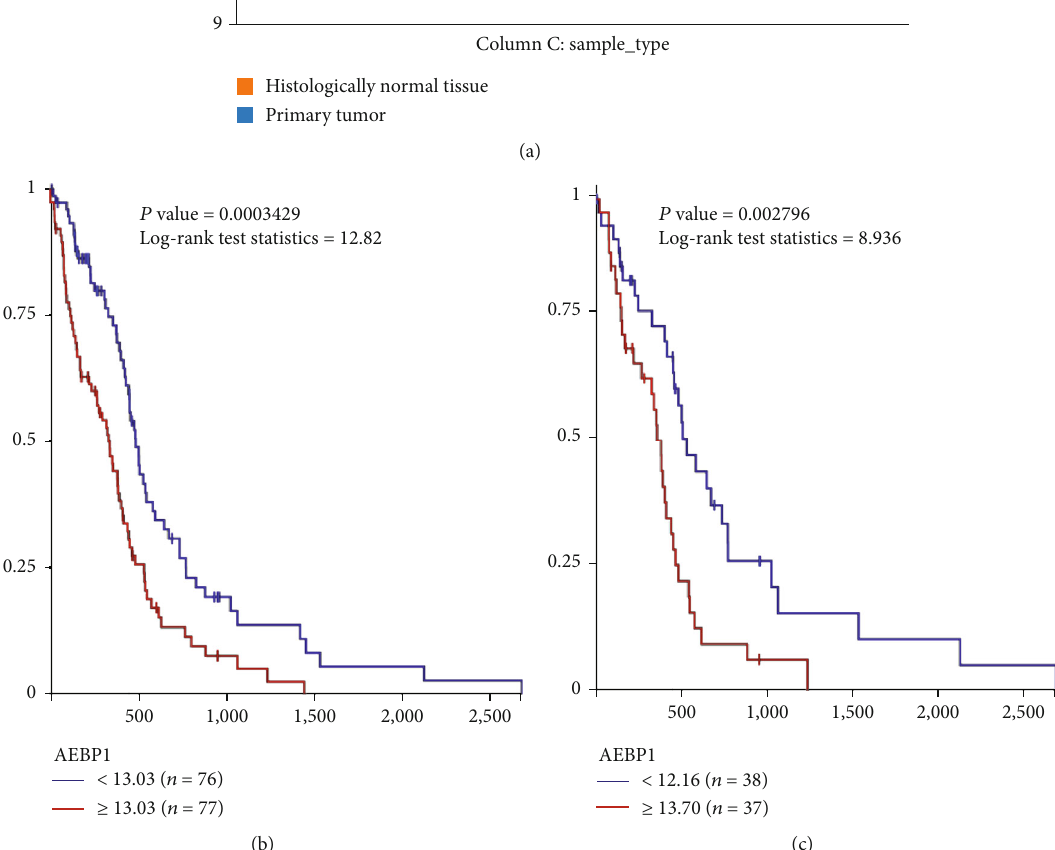
Figure 1: Bioinformatics analysis of AEBP1 expression in GBM: (a) AEBP1 expression in GBM analyzed through the Xena database; (b, c) e ff ect of AEBP1 expression on the overall survival of GBM patients analyzed through TCGA